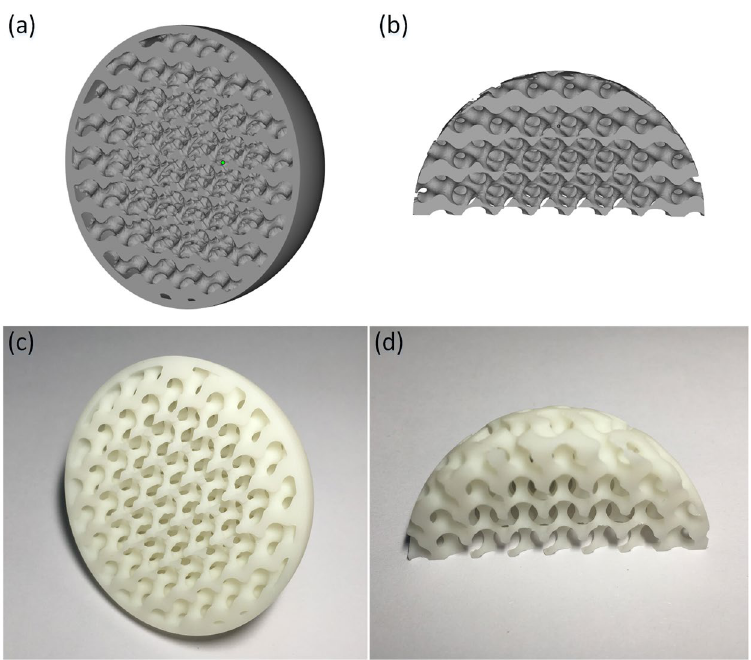
Figure 8. Modeling and fabrication of a porous bionic scaffold: ( a , b ) designed model with gradient structure; ( c , d ) printed bionic porous scaffold